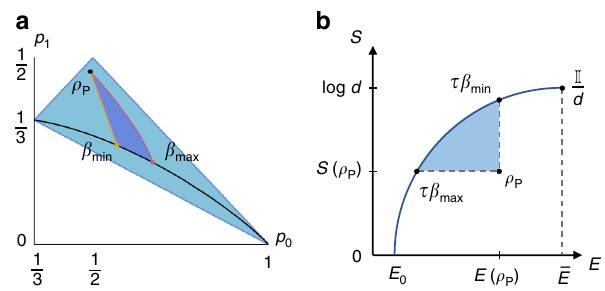
Fig. 5 Instability of passive states and their dynamics. a The state space of a qutrit system, where the region of passive states is highlighted in light blue. The black line contained in the passive region is the set of thermal states. We fi x an initial state ρ P , represented by the black point in the diagram. Then, we evolve this state by applying the cycle S m,n (where m, n → ∞ ) an in fi nite number of times. The evolution is then modulated by the parameter α ¼ n α equal to Δ E 10 Δ E 21 , the system evolves along the yellow trajectory, m . For and the fi nal state is the thermal state at temperature β min (with same average energy of ρ P ). For α ¼ β hot t ð Þ Δ E 10 β , the system evolves along the cold t ð Þ Δ E 21 purple line, and the fi nal state is the thermal state at temperature β max (with same entropy of ρ P ). The dark blue region represents the subset of achievable states when the initial state is ρ P . b A partial representation of the state space of a d -level quantum system in the energy – entropy diagram 32 . In this diagram, quantum states are grouped into equivalence classes de fi ned by their average energy E and their entropy S . Each point between the x -axis (the set of pure states) and the dark blue curve (the set of thermal states) represents one of these equivalence classes. The diagram depends on the Hamiltonian H P of the system. Here, we only represent the states with average energy lower than E ¼ Tr H P ρ , where mm ½ (cid:4) I ρ is the maximally-mixed state, since all passive states are contained mm ¼ d in this set. For a given initial state ρ P , the light blue region contains all the passive states, which can be achieved with the